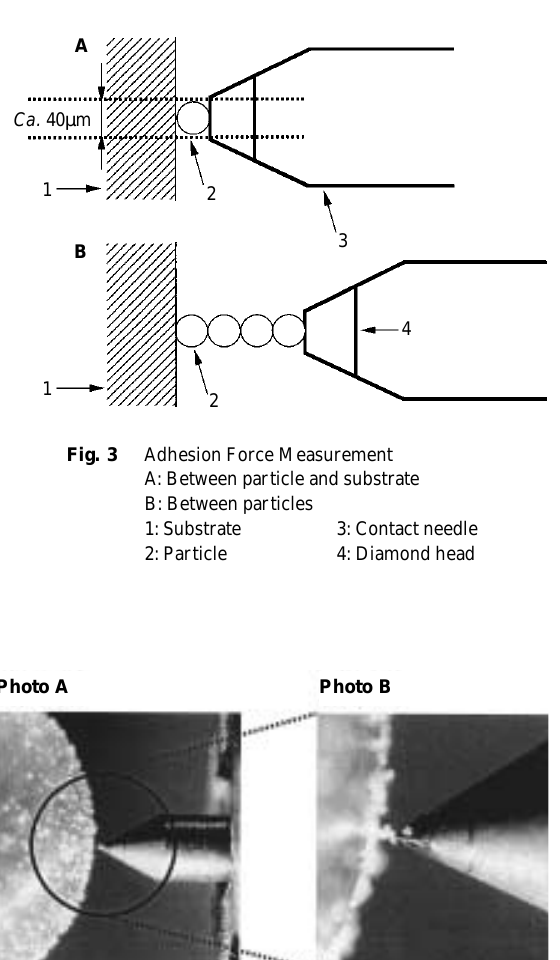
Fig. 4 Contact Needle, Particles, and Capsule Photo A: Particles adhering to a capsule surface Photo B: An enlargement, showing particles just before separation